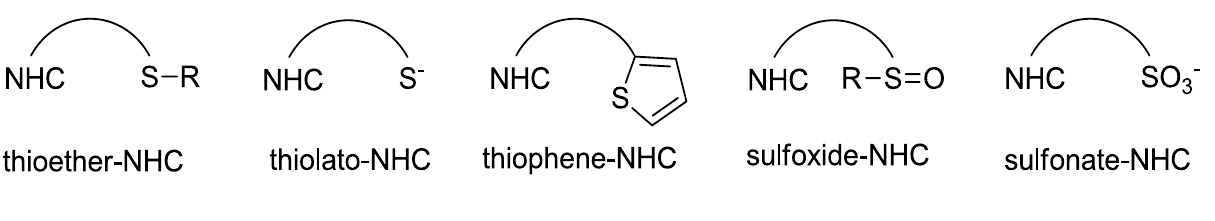
Figure 1. NHCs with different sulfur